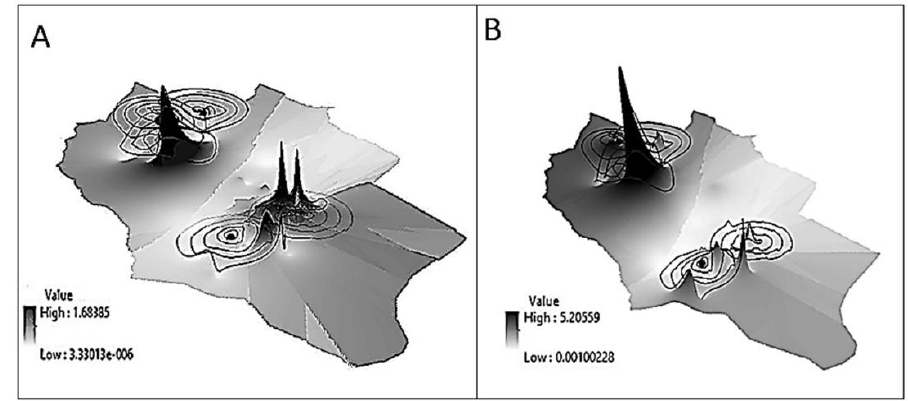
Figure 4. Three-dimensional maps of the tested area showing the power density ( µ W / cm 2 ). With a color gradient. ( A ) Outside the houses. ( B ) Inside the houses. The color gradient showing the average power density.